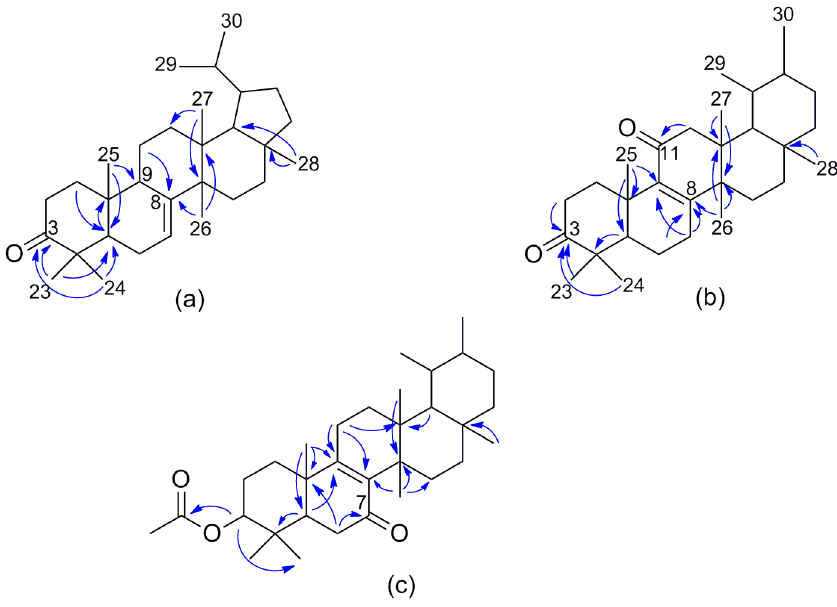
Figure 2. Selected HMBC (blue arrows) for compounds 1 ( a ); 2 ( b ); and 3 ( c ). Table 1. 1 H- and 13 C-NMR spectral data a of 1 – 3 in CDCl 3 .